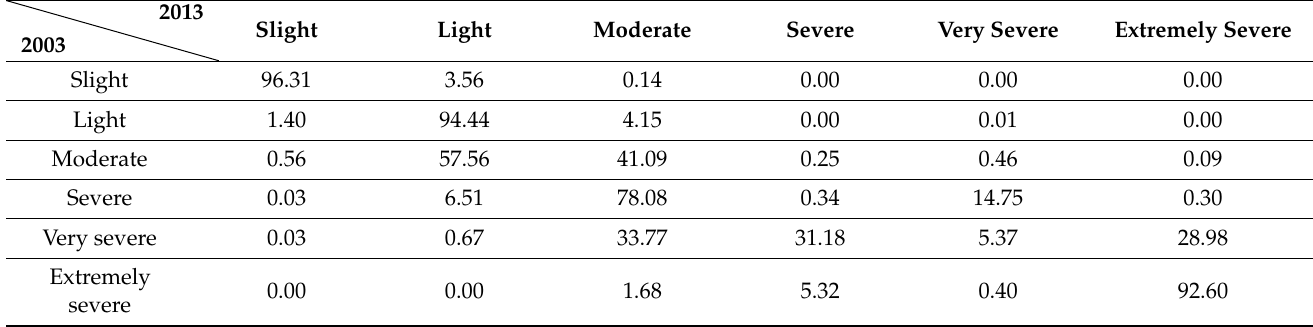
Table 7. Transition matrix of different land-use types from 2003 to 2013 (%).